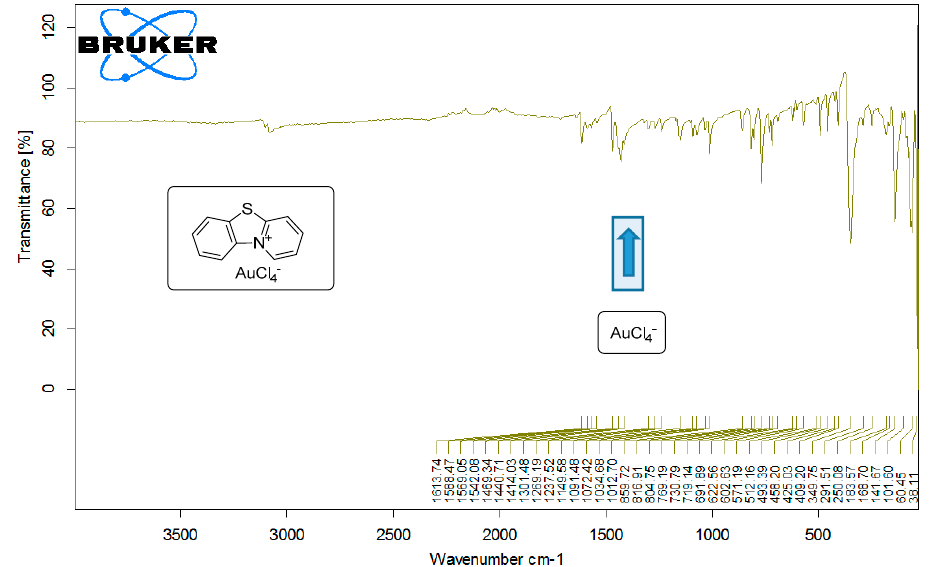
Figure 2. Far–IR spectrum of the tetrachloroaurate(III) salt 8b.